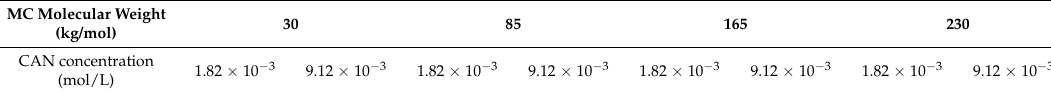
Table 1. Molecular weight of MC and CAN concentration used for the synthesis of MC-g-PNtBAm